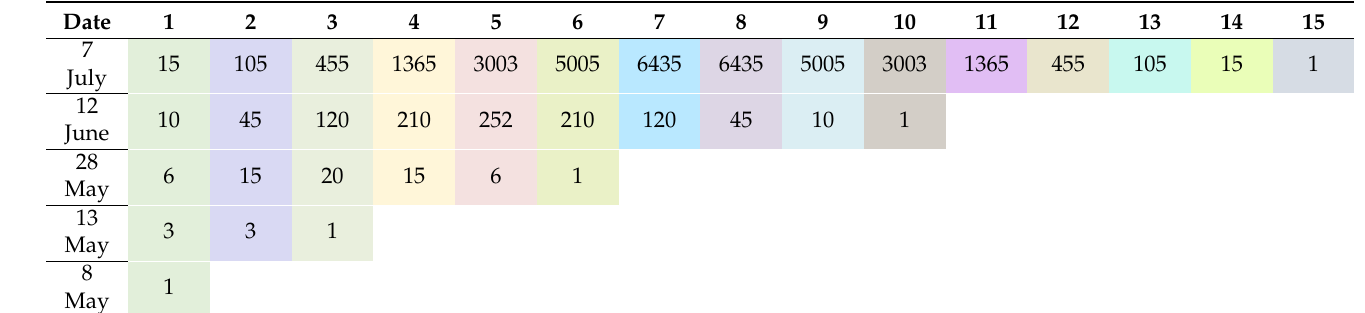
Table 6. All possible combination types at each stage and the number of images contained in each